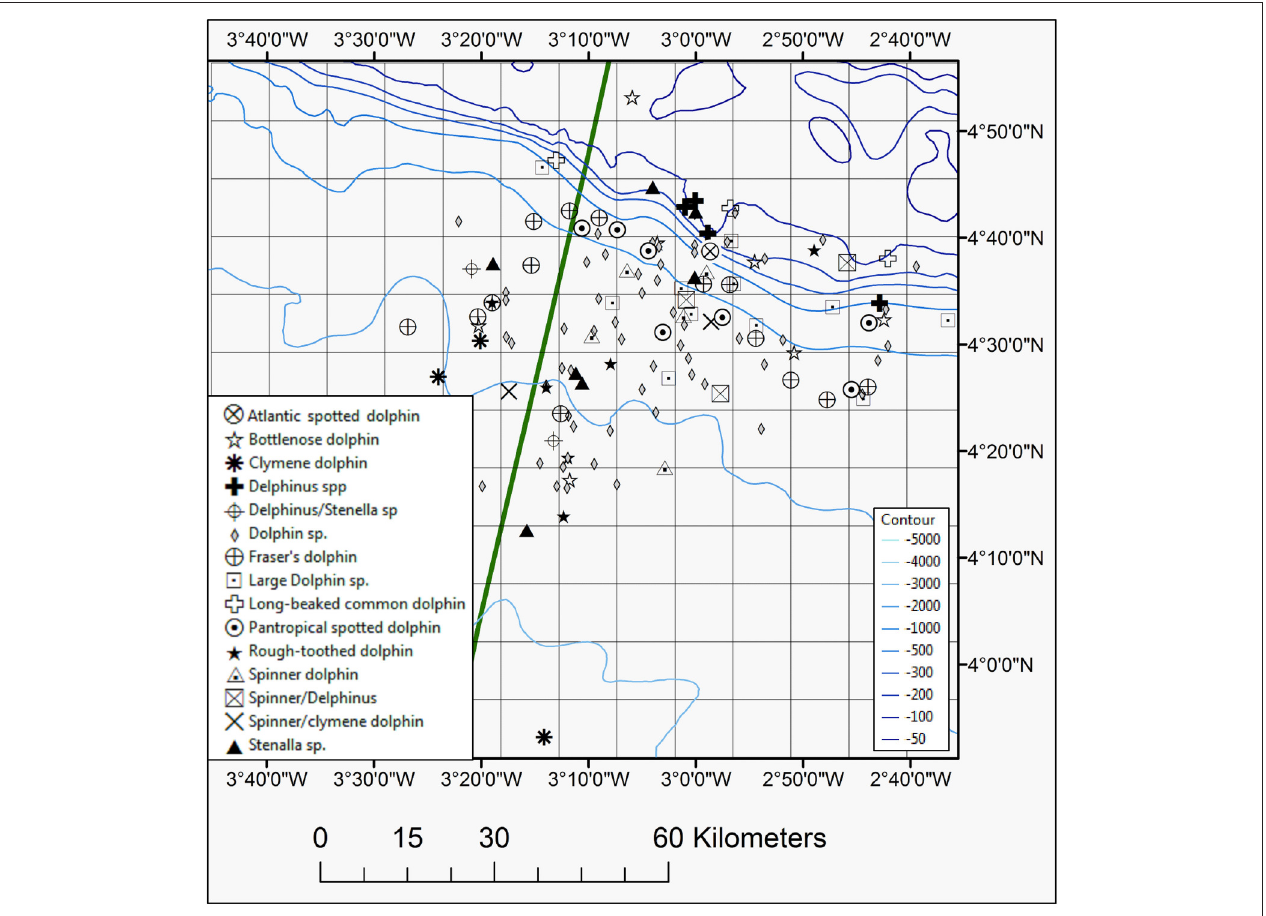
FIGURE 5 | Map showing positions of all dolphin species seen during the 2013 and 2014 surveys, including Atlantic spotted, bottlenose, Clymene, Delphinus spp., long-beaked common, pantropical spotted, rough-toothed, Fraser’s, and spinner dolphins. The EEZ border between Côte d’Ivoire and Ghana is also shown (green thick